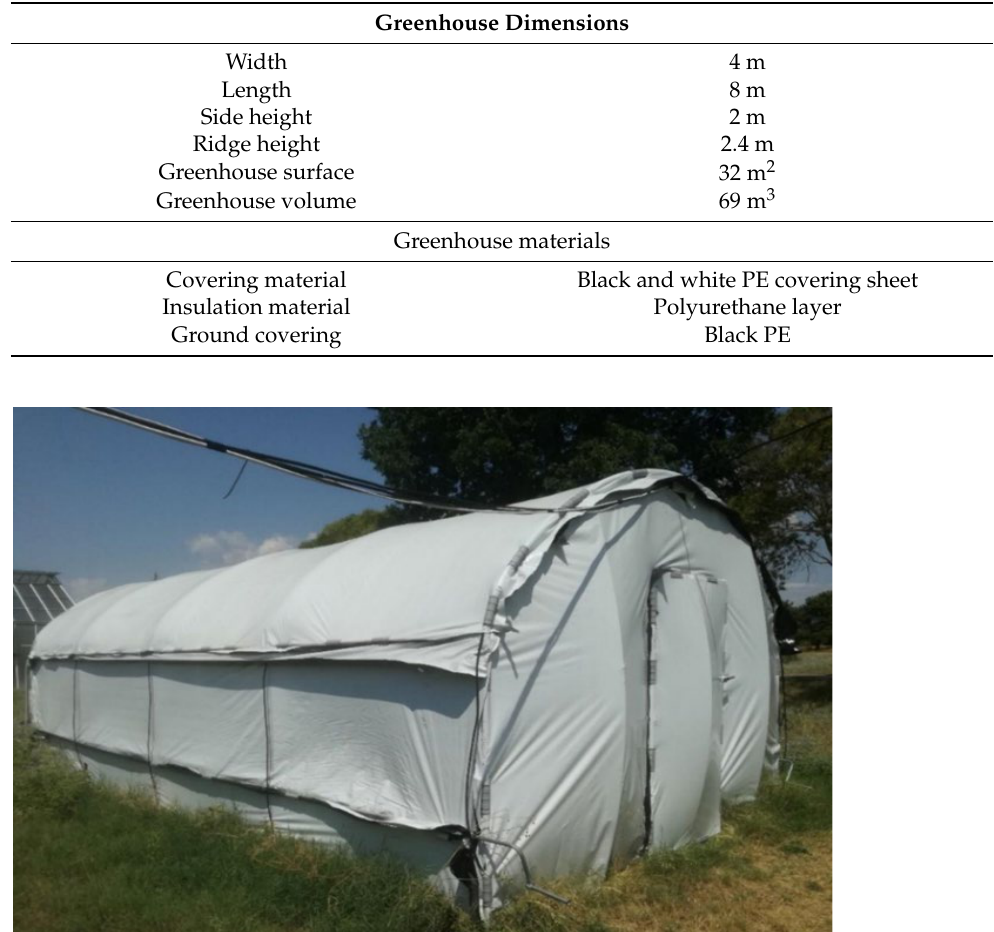
Table 1. Greenhouse structure description.